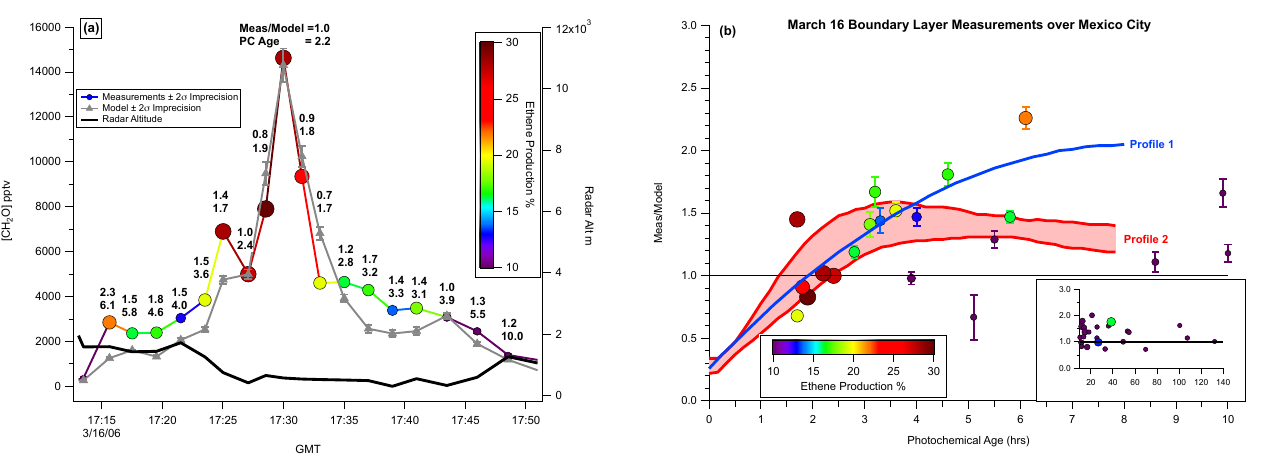
Fig. 11a. TDLAS measurement and model time series on the hy- drocarbon time base during a flight segment in the boundary layer over the central part of Mexico City on 16 March 2006 downwind of two large VOC emitting facilities. The 2 σ measurement and model uncertainties are shown with each data point by the error bars (the measurement error bars are smaller than each point size). The measurements are colored and sized by the ethene production per- centage from the box model. The numbers above each comparison point represent the measurement/model ratio (upper number) and the photochemical age (PC Age, hours) derived from the ratio of 2-butyl nitrate to butane (Bertman et al., 1995; Perring et al., 2010) employing instantaneous measured OH concentrations on the DC- 8. The solid black line shows the radar altitude (right hand y-axis).